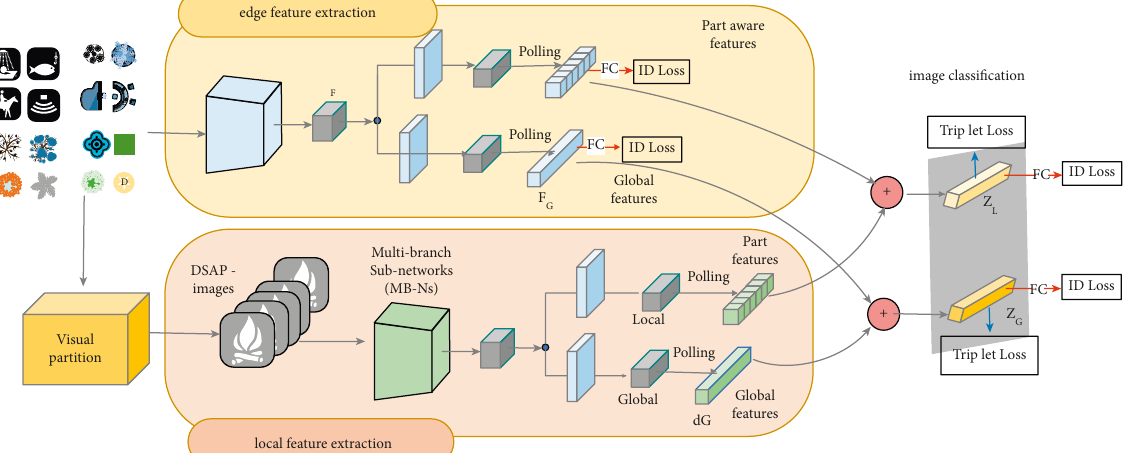
Figure 1: The application framework of digital technology in visual